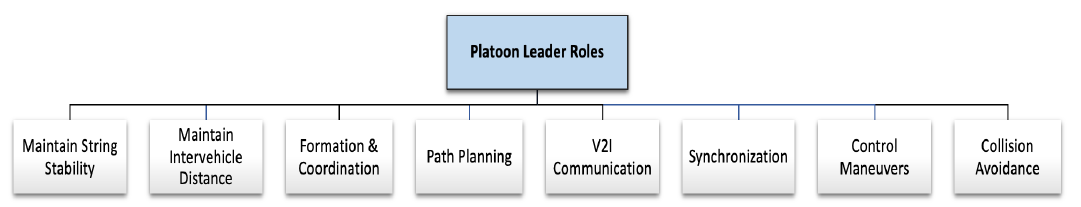
Figure 7. Role and responsibilities of platoon